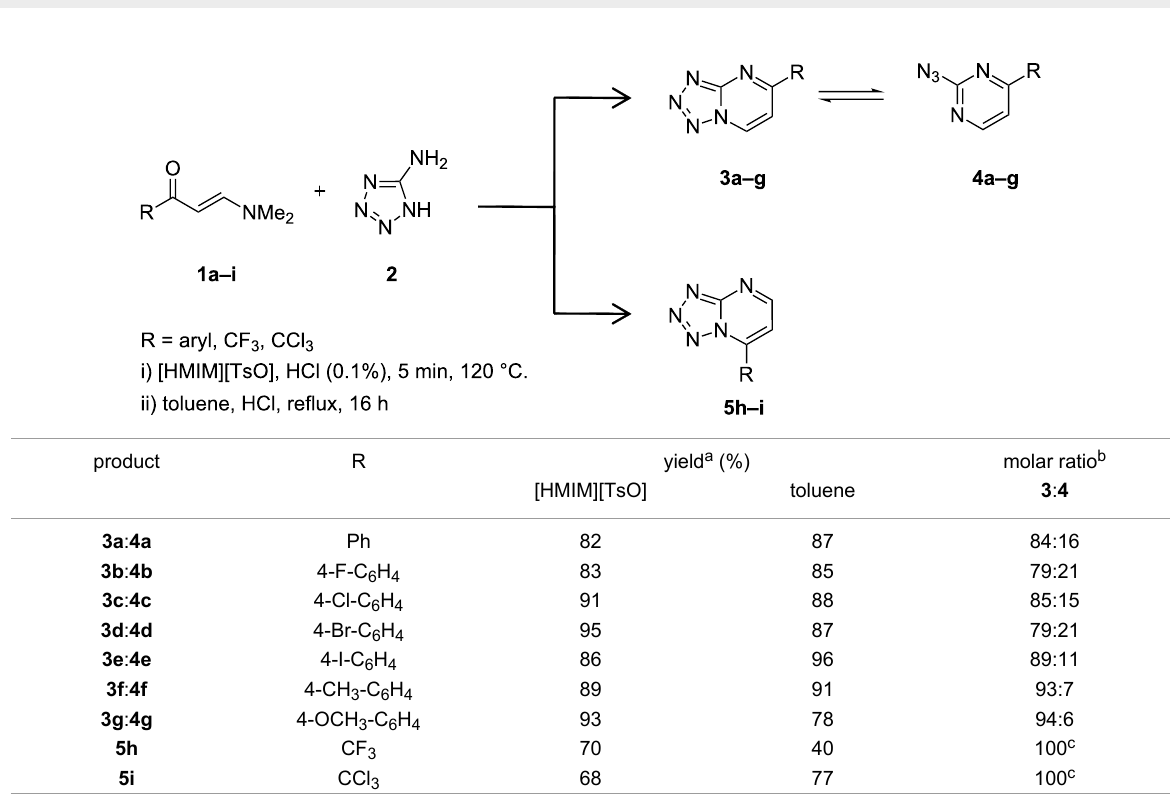
Table 2: Synthesis of compounds 3a–g , 4a–g and 5h , i